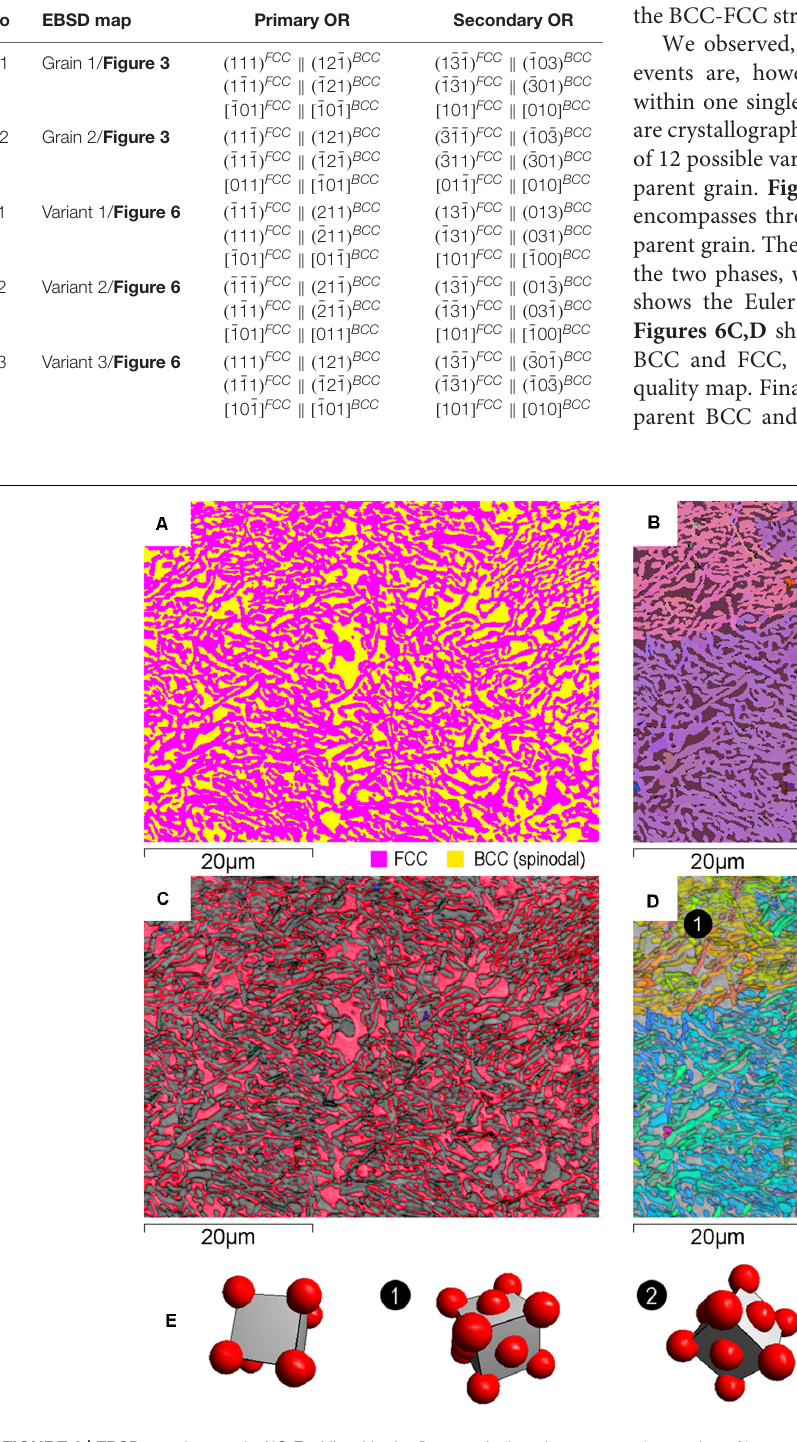
Frontiers in Materials |